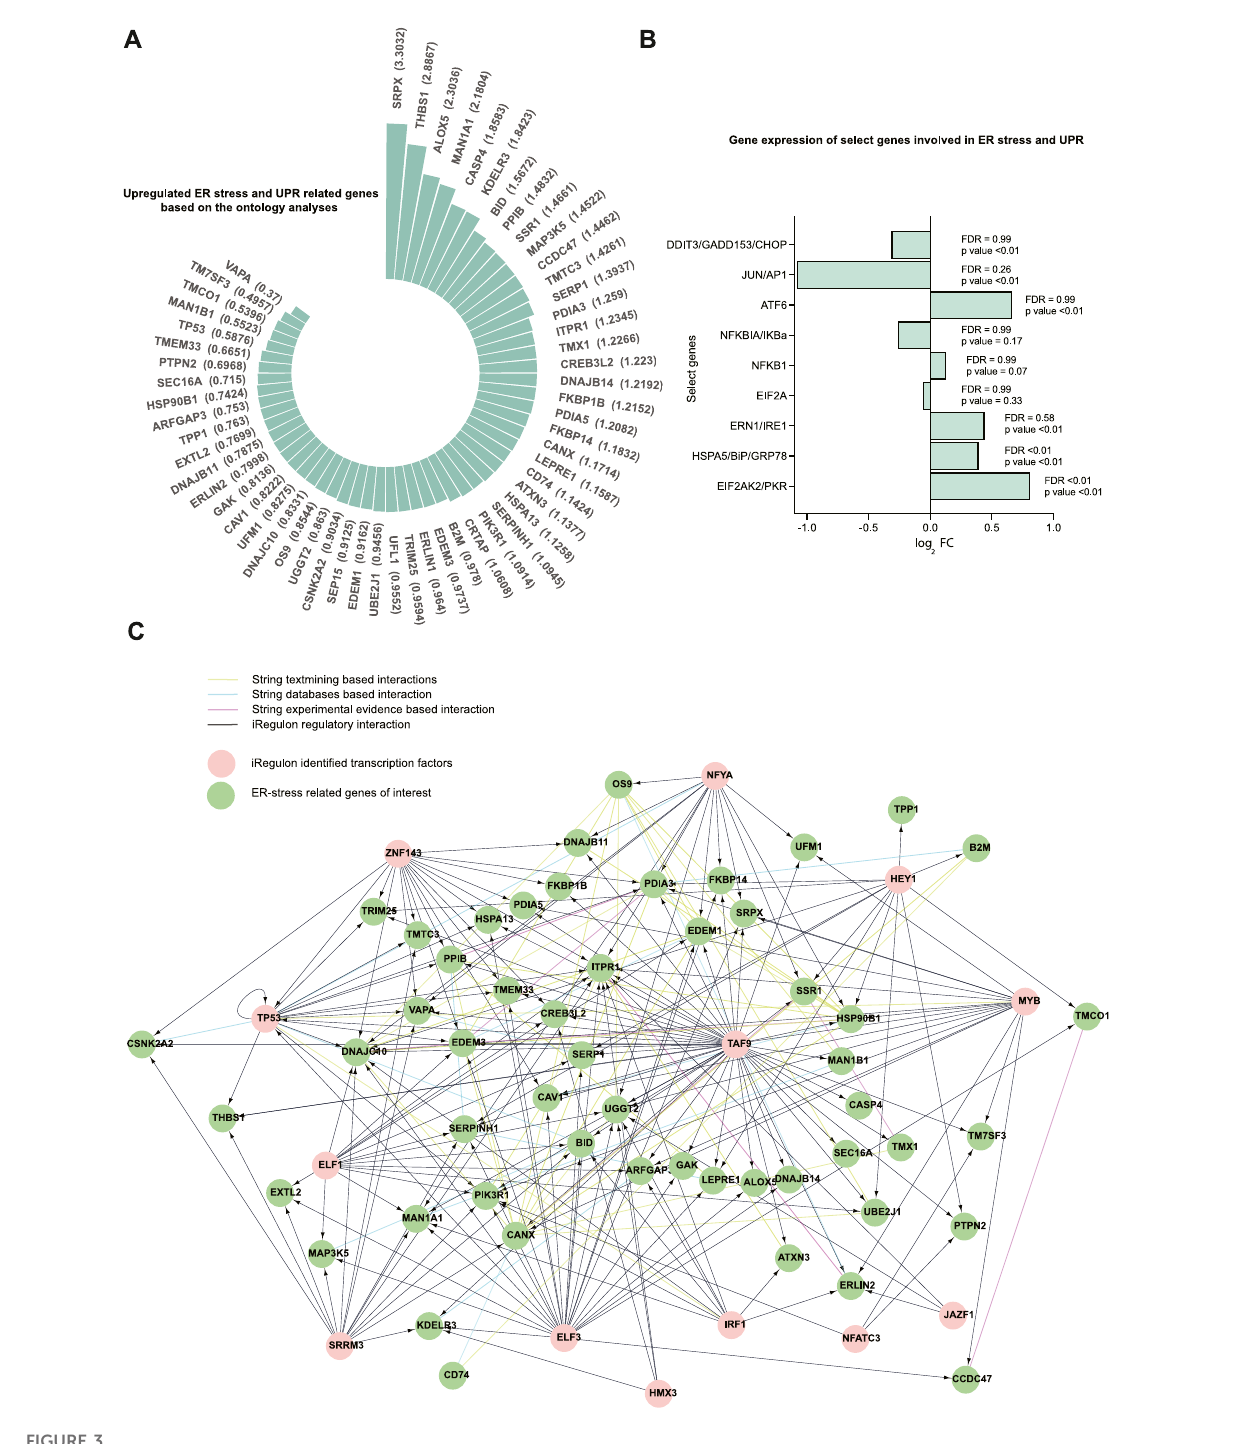
A total of 58 upregulated genes related to ER stress and the UPR were identi fi ed in the human Affymetrix chip data analyzed. (A) Fold changes (log 2 FC) for the 58 upregulated ER stress and UPR-related genes (FDR ranged from 2E-09 to 0.03). Differential expression was analyzed using the Limma package in R. The 58 genes were selected from the 24 GO processes that are related to ER stress and the UPR. (B) Representation of gene expression of select genes subsetted from the human Affymetrix chip data corresponding to the proteins immunoblotted in DBA and D2-mdx mice. (C) The network for the genes of interest and their transcriptional regulators is created using Cytoscape incorporating the String interactions (with a high interaction score of 0.7) and transcription factors identi fi ed using iRegulon (NES cutoff = 4). The top 13 transcriptional regulators are